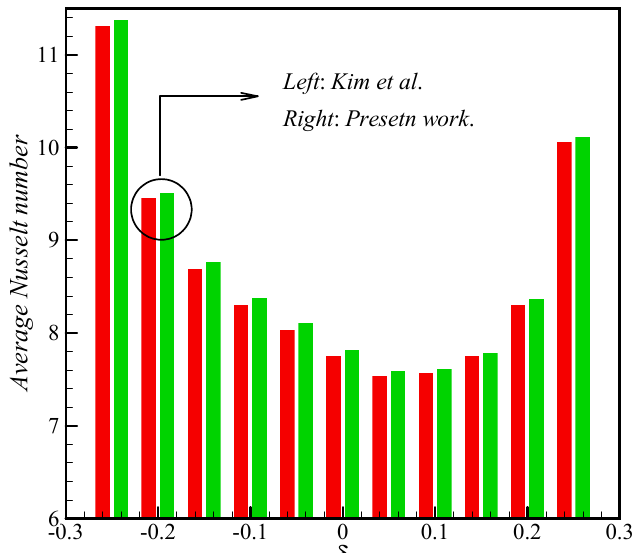
Figure 4. Isotherms from experiments of ( a ) Calcagni et al. [38] and ( b ) numerical data from the present study at Ra = 1.425 × 10 5 , Ha = 0.0, Mn f = 0.0, φ = 0.0, and Pr = 0.71.